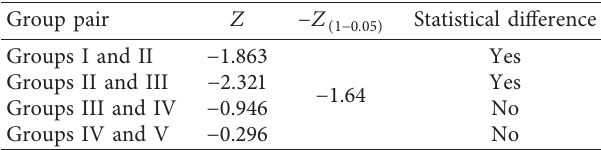
Statistical difference 1 − 0 . 05 )